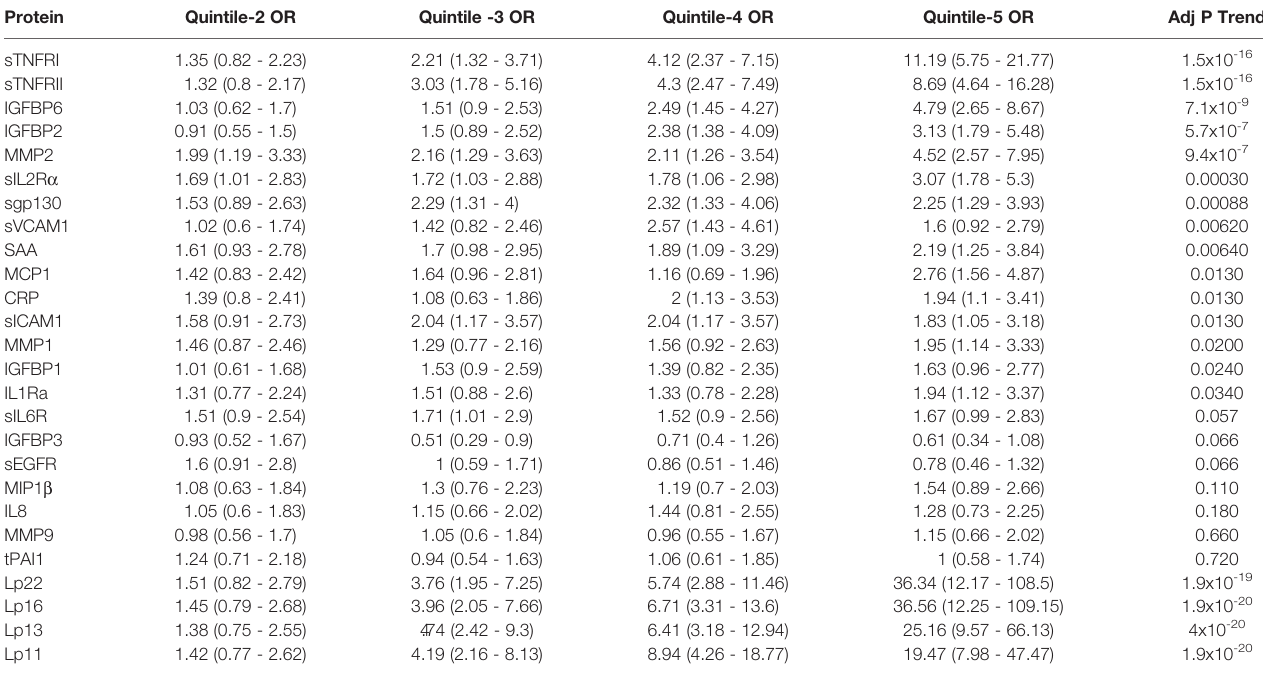
TABLE 3 | Odds ratio (95% CI) of having DPN based on serum levels in quintile (20 th percentile) categories. Protein Quintile-2 OR Quintile -3 OR Quintile-4 OR Quintile-5 OR Adj P